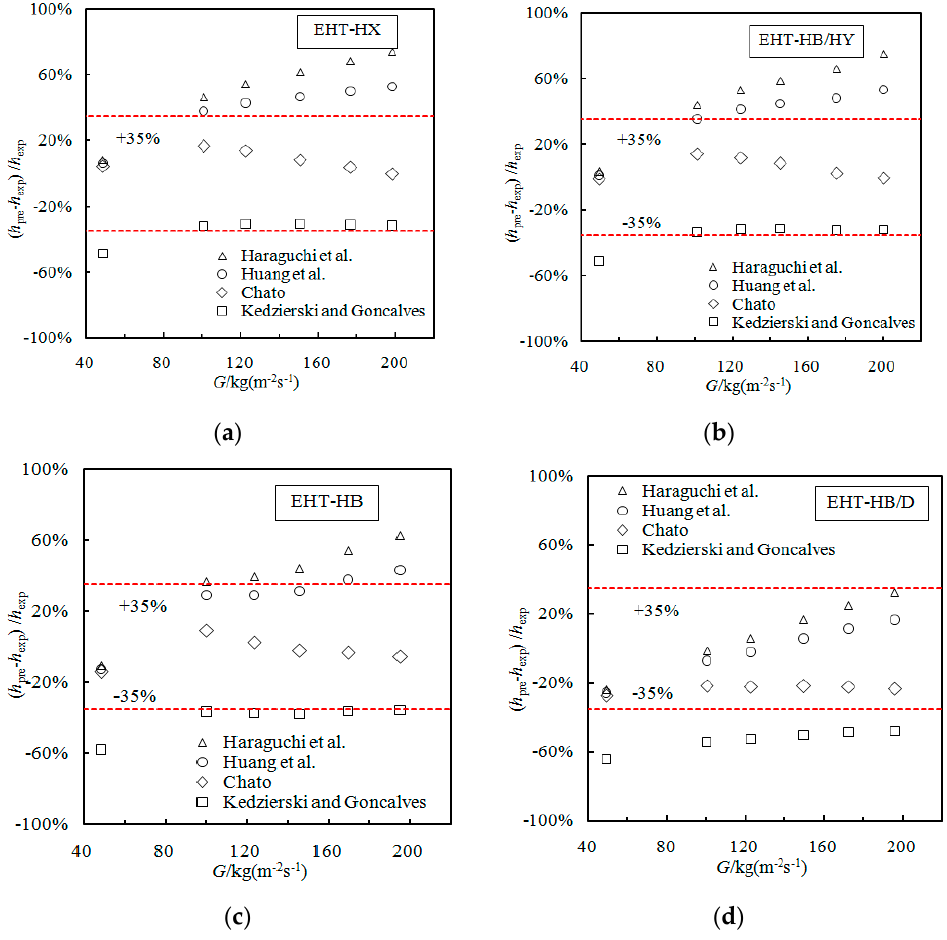
Figure 6. Comparison of using Haraguchi et al. [27]; Huang et al. [28]; Chato [29]; Kedzierski and Goncalves [30] correlations to predict performance for ( a ) EHT-HX, ( b ) EHT-HB/HY, ( c ) EHT-HB, and ( d ) EHT-HB/D. Table 2. Modified Haraguchi et al.